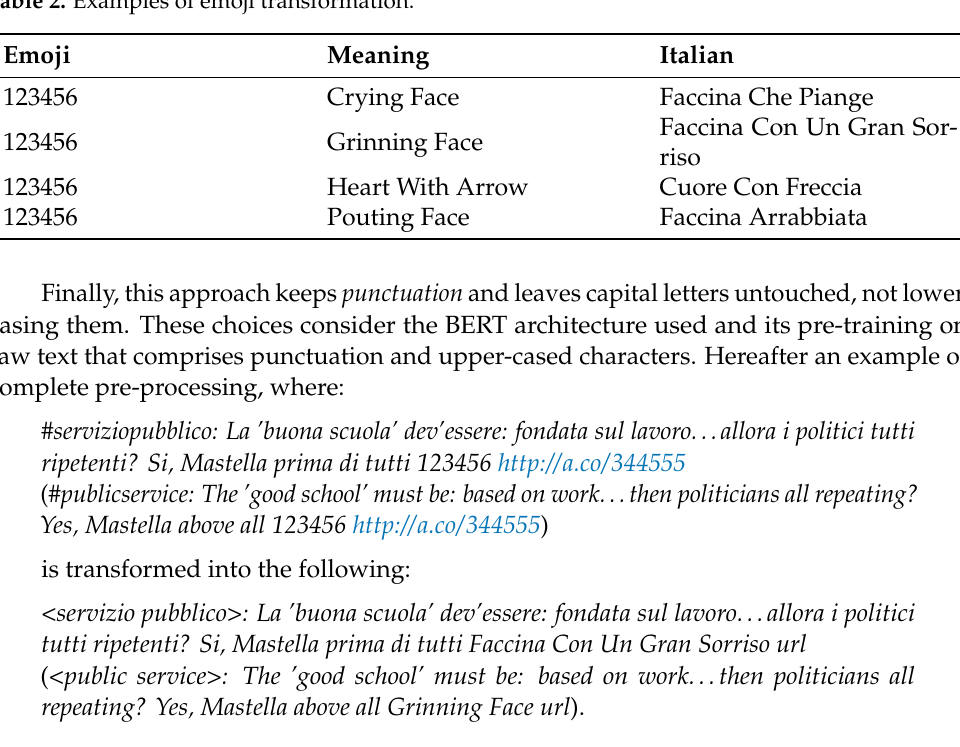
Table 2. Examples of emoji